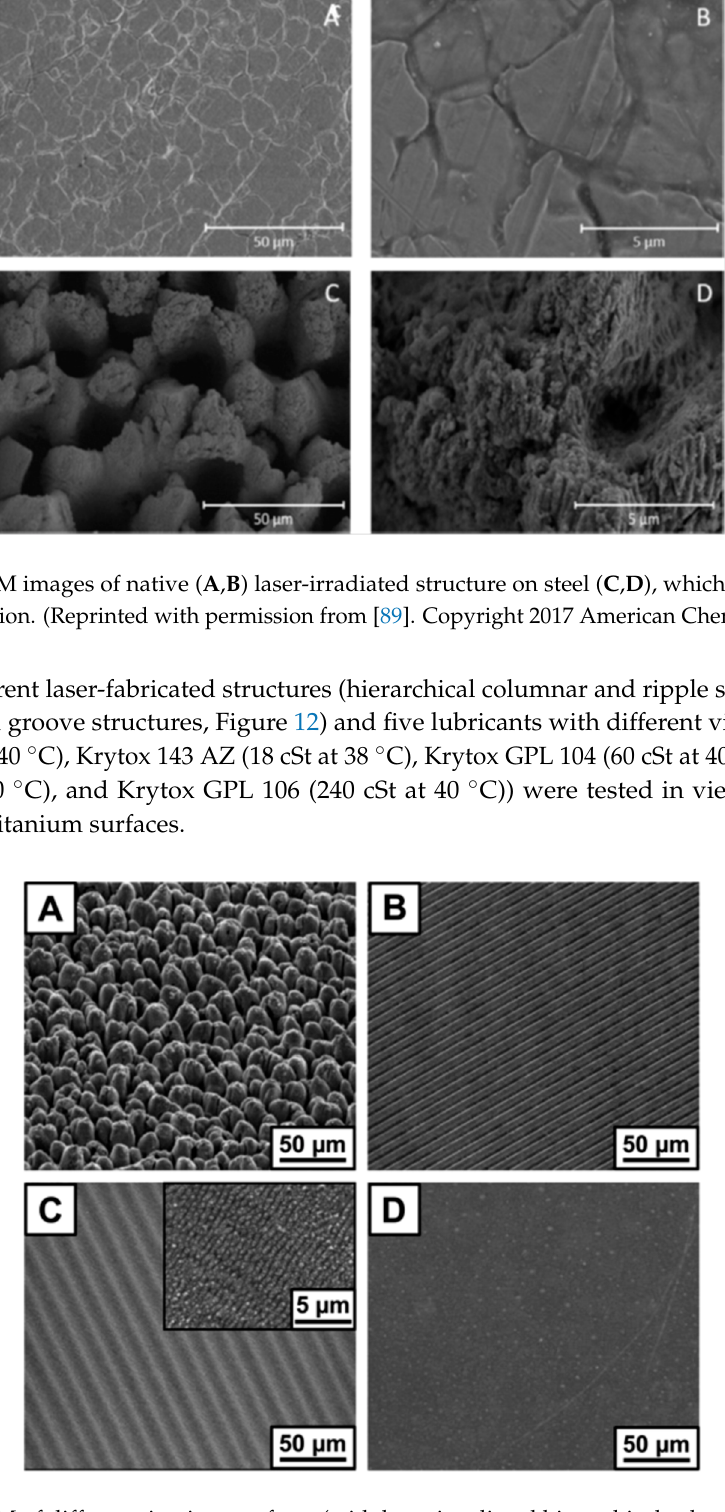
Figure 12. SEM of different titanium surfaces (with laser-irradiated hierarchical columnar structure ( A ) with laser-inscribed grooves structure ( B ), with laser-irradiated ripples structures ( C ), native ( D )), which was tested in [90] for fabrication of SLIPS. (Reprinted with permission from [90]. Copyright 2017 American Chemical Society.)